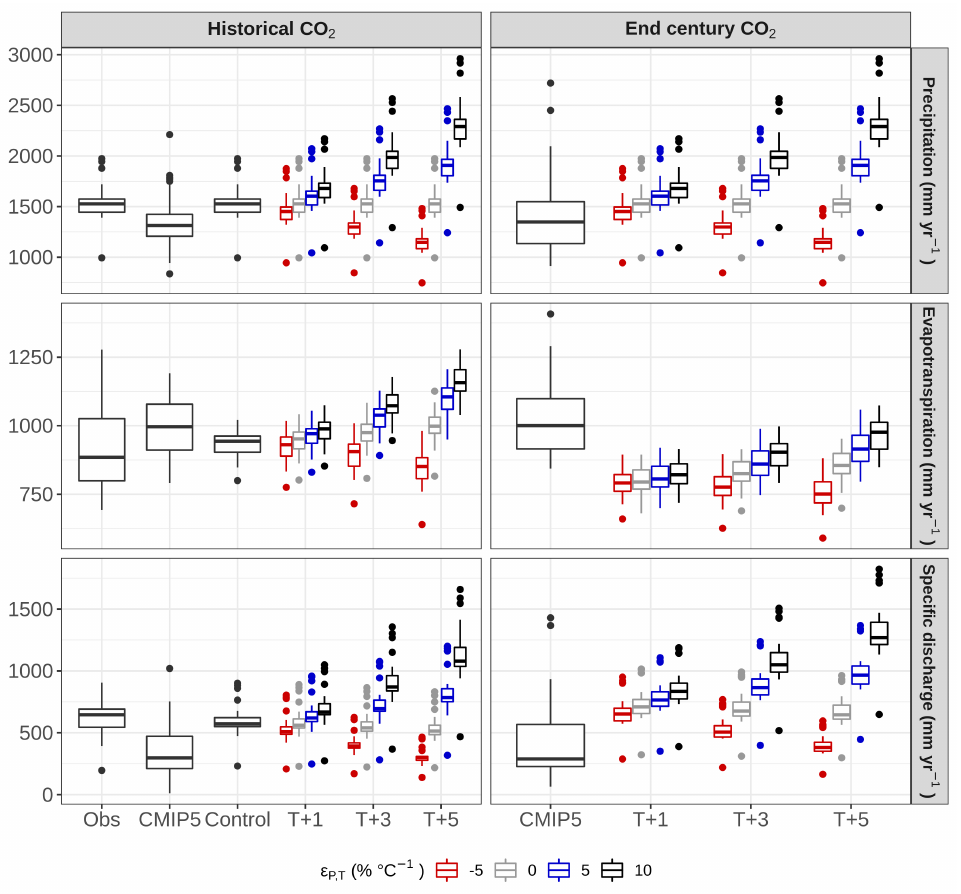
Figure 8. Boxplot distribution of yearly values of P ( top ), ET ( middle ), and Q ( bottom ), all in mm yr − 1 , with the temporal distribution of observational data (Obs); distribution among CMIP5 model output ensembles (CMIP5); temporal distribution of control simulation (Control); and tempo- ral distribution of current experiments shown for: temperature increase of T + 1, T + 3, and T + 5 ◦ C all for the alike RH case; the elasticity of precipitation to the temperature ( − 5; 0; 5; 10% ◦ C − 1 , colors) and CO 2 concentration cases (historical, left column, and end 21st Century, right column). The ob- servations used field water budget with P and Q measures and ET = P -Q; for CMIP5 outputs, the historical (end of the century) CO 2 cases ranged between 1980 and 2004 (2075 and 2099), respectively, in the RCP 8.5 scenario, with estimates of Q = P